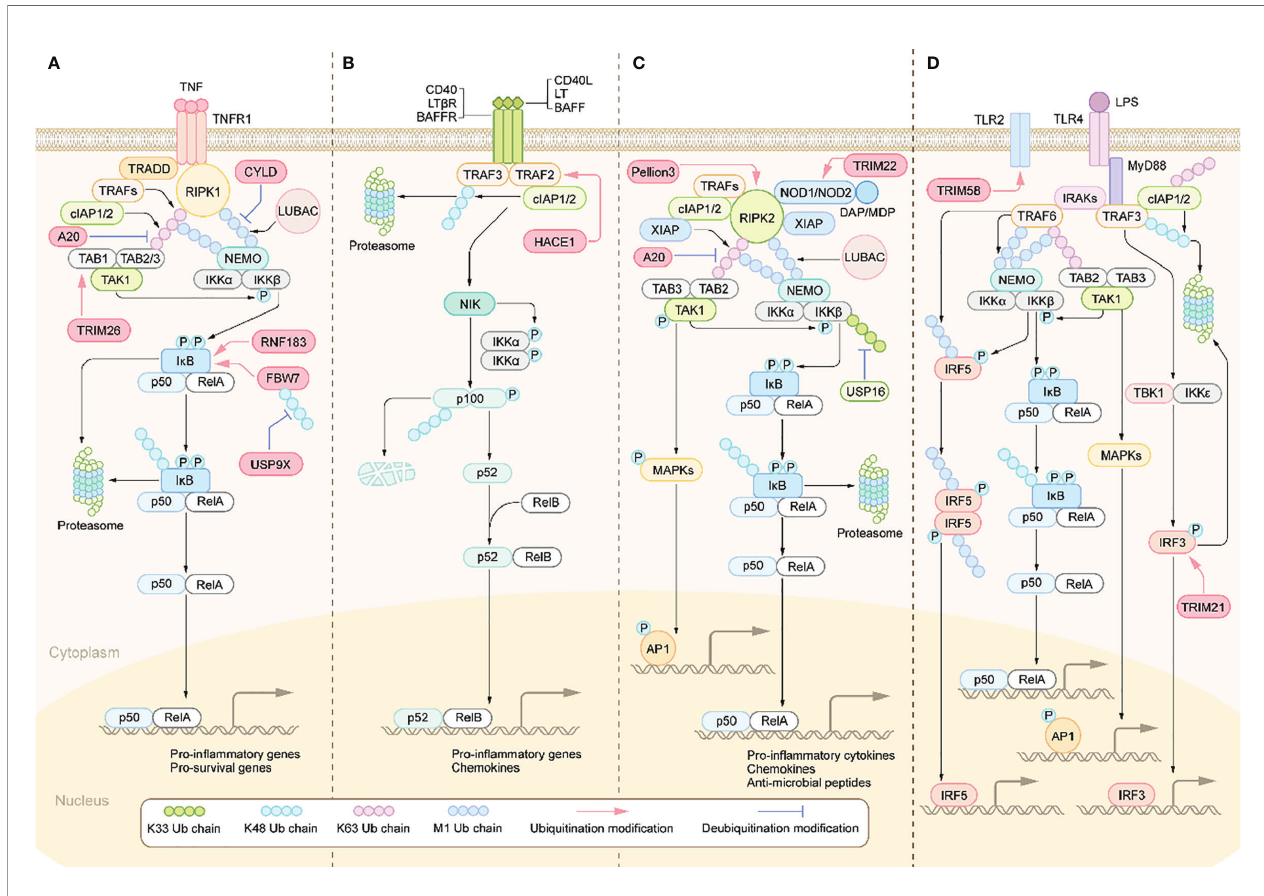
FIGURE 1 | Activation and regulation of NF- k B pathway. (A) Canonical NF- k B activation: The binding of TNFRs to the ligands leads to the recruitment of TRADD, RIPK1. TRADD subsequently recruits E3 ubiquitin ligases, including TRAFs, cIAP1/2 and LUBAC. RIPK1 is then ubiquitinated and acts as a ubiquitin scaffold to recruit the IKK complex and the TAK1 complex. The IKK complex is comprised of IKK a , IKK b , and NEMO. The TAK1 complex consists of TABs and TAK1.TAK1 further phosphorylates and activates IKK b , which in turn induces phosphorylation and degradation of I k B a , allowing NF- k B dimers to translocate to the nucleus and drive transcription of target genes. (B) Non-canonical NF- k B activation: The interaction of the receptor with the corresponding ligand recruits TRAFs and cIAP1/2 proteins to the receptors, resulting in their ceasing to mediate the ubiquitinated proteasomal degradation of NIK, leading to stabilization and accumulation of NIK and ultimately activation of the NF- k B pathway and transcription of target genes. (C) NODs-mediated NF- k B and MAPKs activation pathways. DAP, MDP binds to NOD1 and NOD2 receptors in the cytoplasm, respectively, which recruit RIPK2, cIAP1/2, and XIAP. rIPK2 undergoes IAP-mediated ubiquitination modi fi cations and acts as a ubiquitin scaffold to recruit the TAK1 complex, the IKK complex and LUBAC. subsequently, TAK1 further activates the IKK b /I k B/NF- k B signaling cascade. In addition, TAK1 also leads to the activation of MAPKs, which induce transcription of AP1 target genes. (D) Activation of TLRs triggers the MYD88-dependent signaling cascade that induces NF- k B and MAPK signaling activation. MYD88 recruits IRAKs, which then activates TRAF6. TRAF6 then recruits the TAK1 complex and the IKK complex. IKK b is then phosphorylated by TAK1, which in turn phosphorylates I k B to activate NF- k B. TAK1 also activates the MAPK signaling cascade. The signaling cascade induced by TLRs also activates IRF3 and IRF5. Activated transcription factors translocate to the nucleus and induce the production of pro- in fl ammatory cytokines and type I